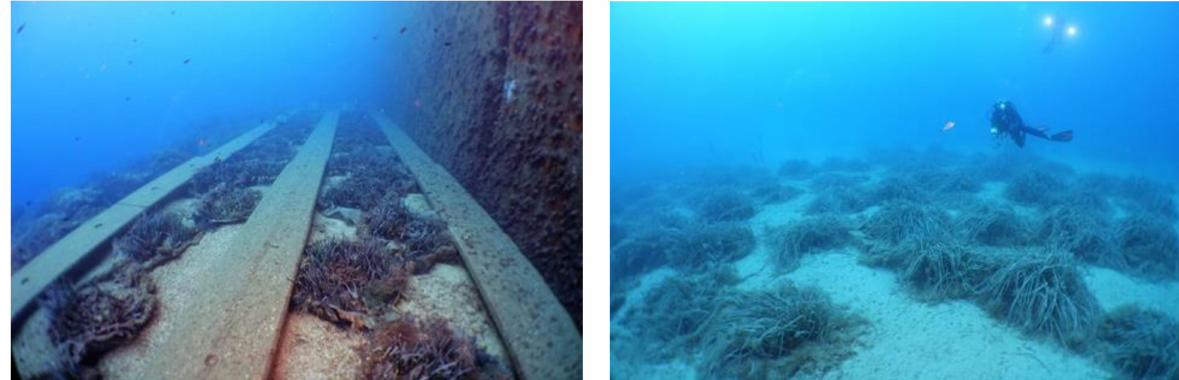
Figure 10. ( Left ) The excavator, on a pontoon anchored to the bottom. From Descamp et al. [236]. Courtesy of the author. ( Right ) A view of the clod transplanter in operation. Photo © Androm è de oc é anologie. Courtesy of the author.